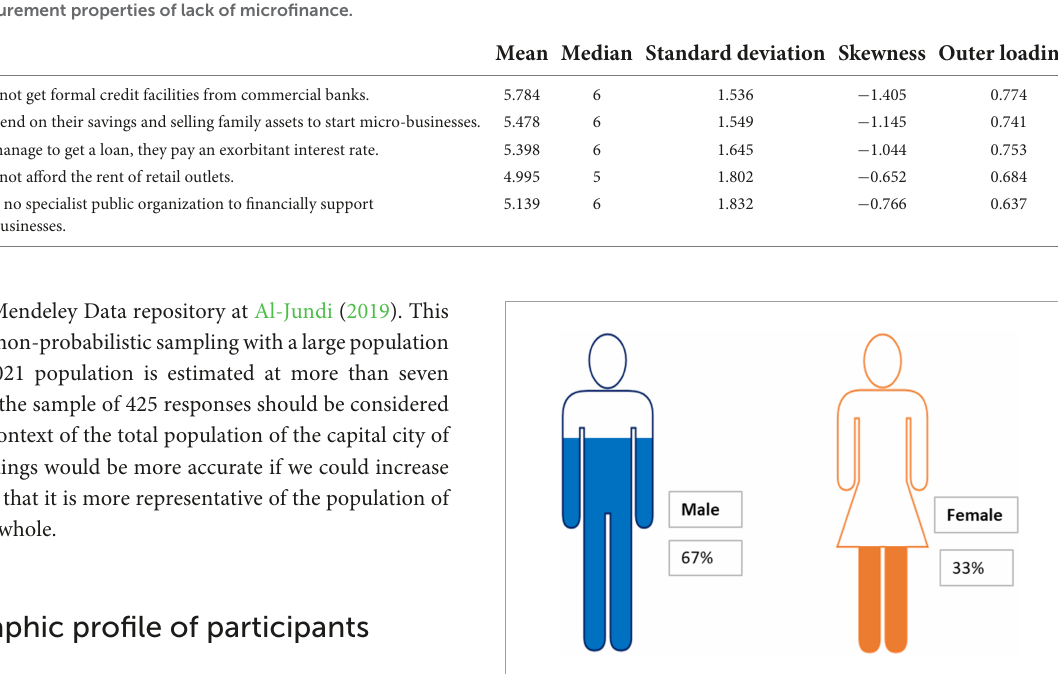
TABLE 9 Measurement properties of lack of microfinance.